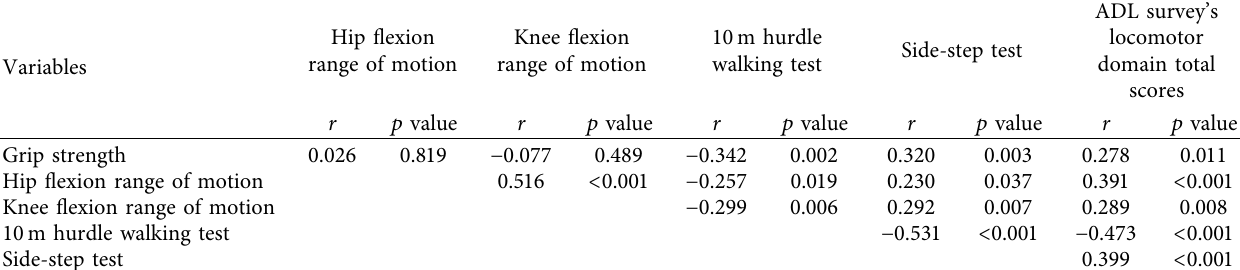
Table 4: Pearson correlations between variables in older women ( n � 83).